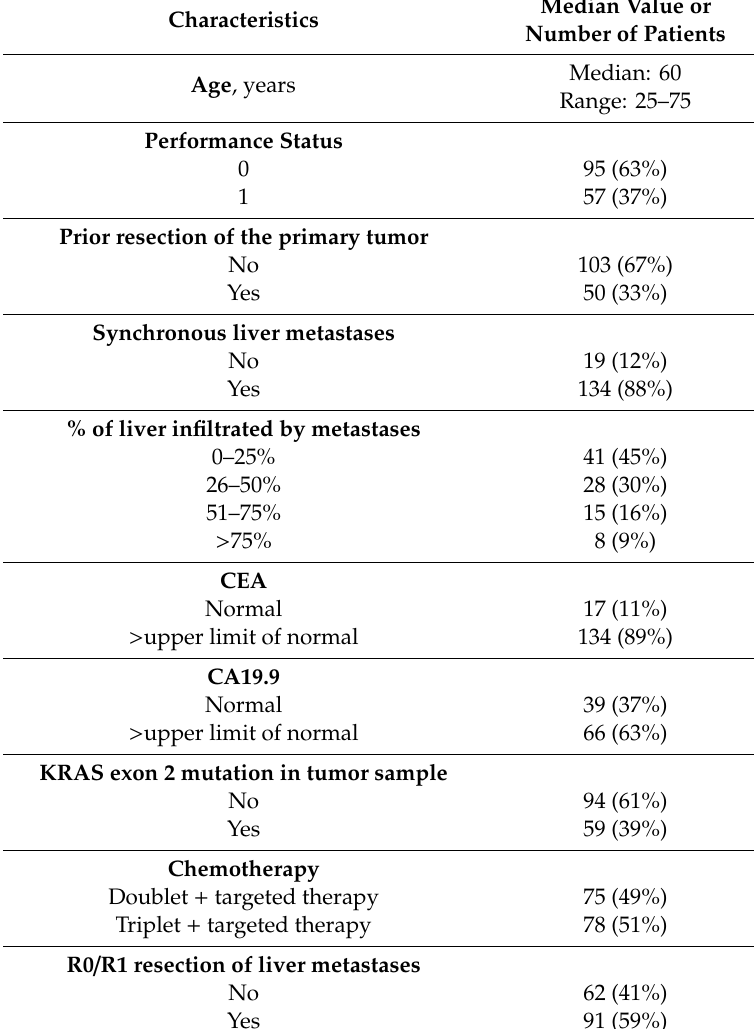
Table 1. Patients characteristics. N = 153 patients included in the